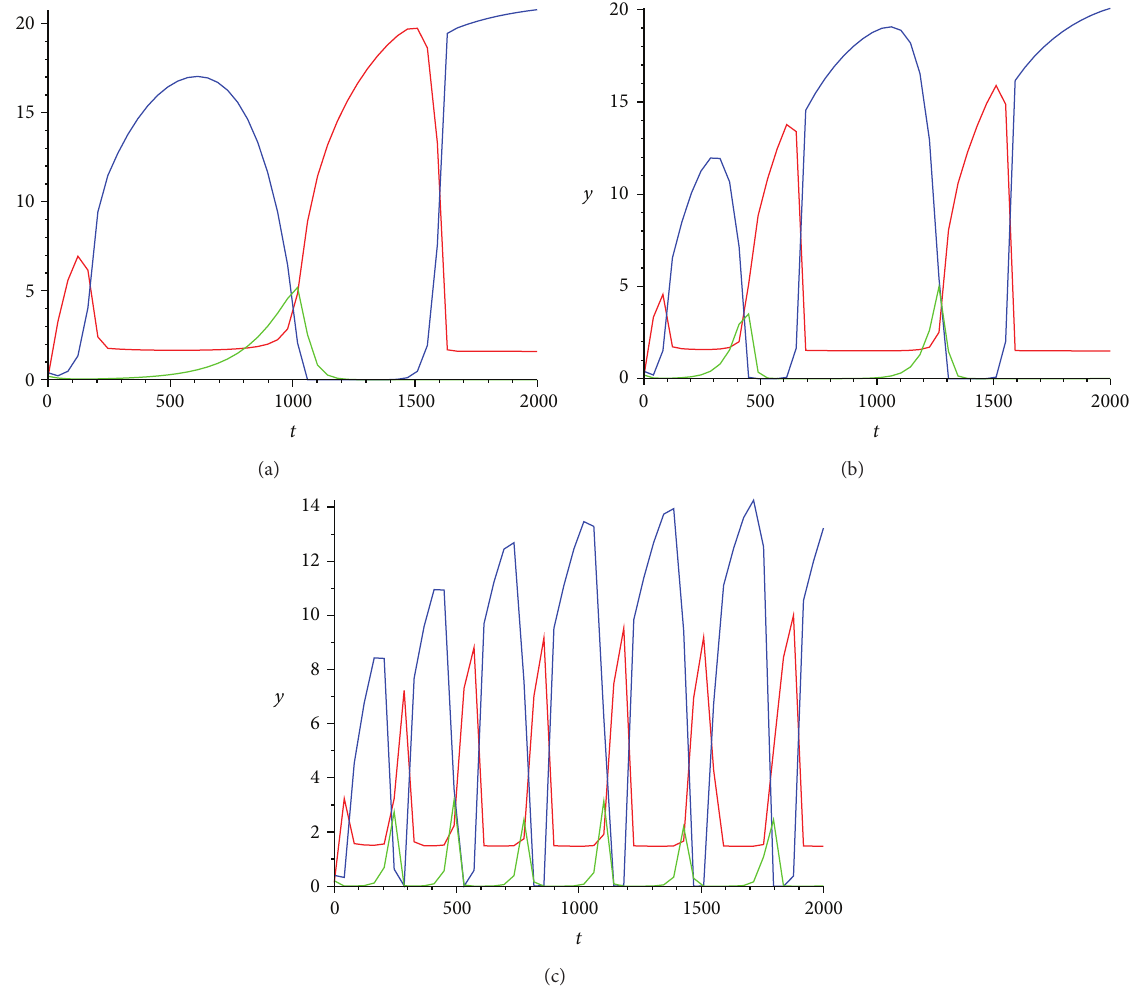
Figure 3: (a), (b), and (c) are time series of nutrient, phytoplankton, and zooplankton for 𝑇 = 10, 18, 27 , respectively, where the thick line is the phytoplankton curve, the middle line is the nutrient curve, and the thin line is zooplankton curve.